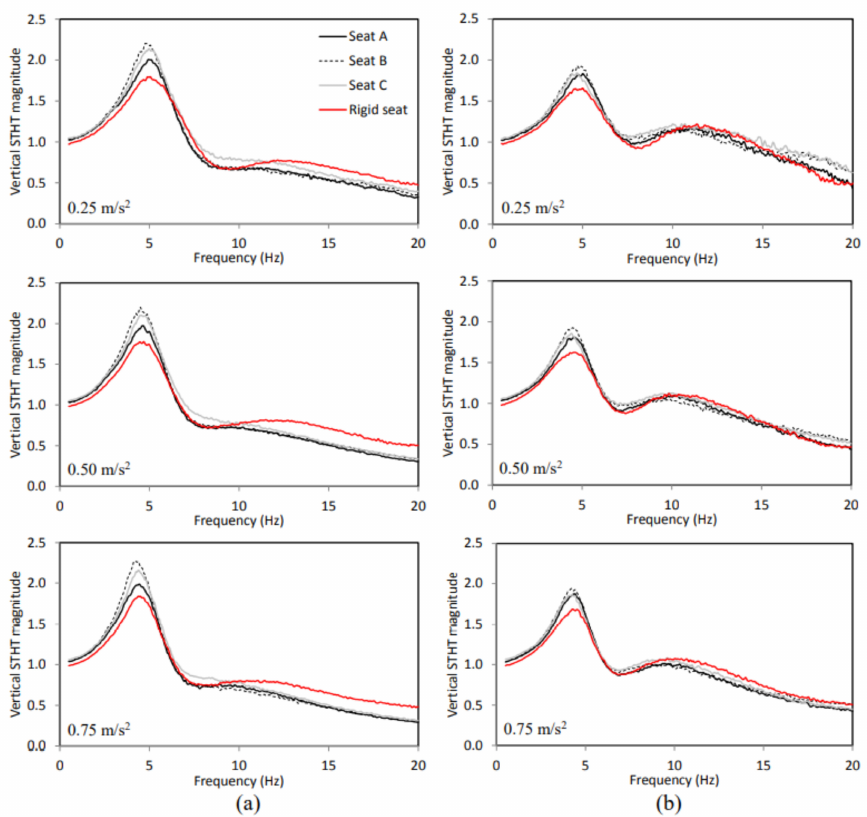
Figure 6. Mean vertical STHT magnitude of 58 participants sitting on the elastic and rigid seats under three excitations: ( a ) without back support; and ( b ) with back